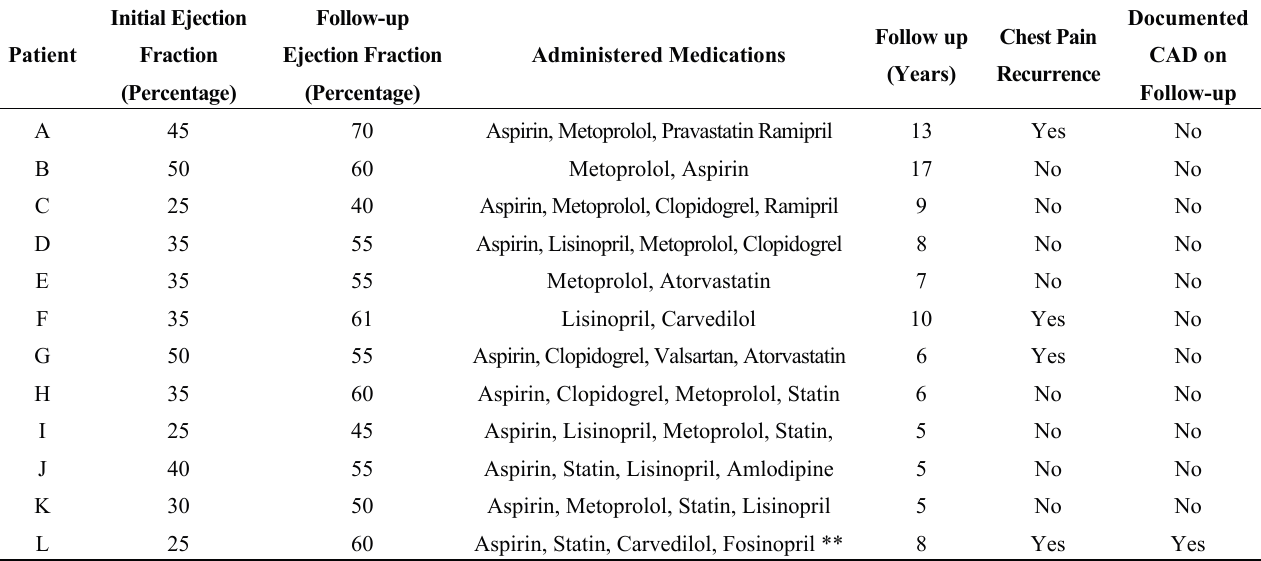
Table 3. Management and follow up.